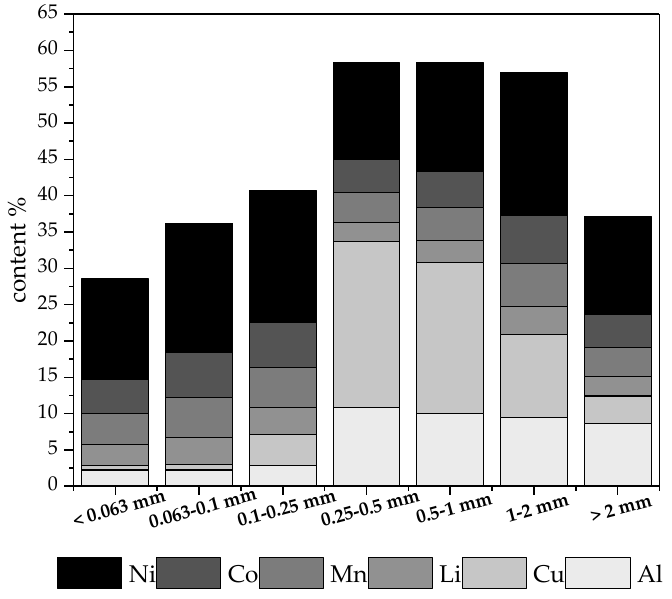
Figure 3. Distribution of main metal contents in different size fractions.